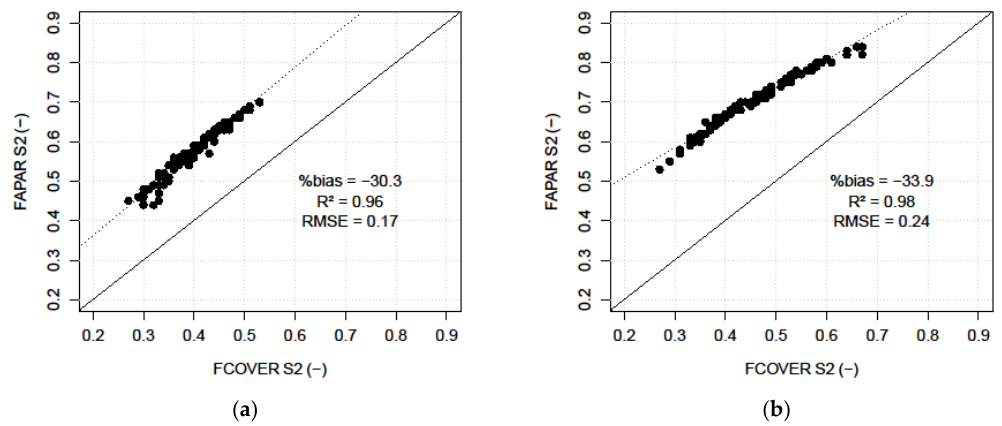
Figure 6. FCOVER-S2 plotted (black dots) against FAPAR-S2 across the study site in the spring ( a ) and summer ( b